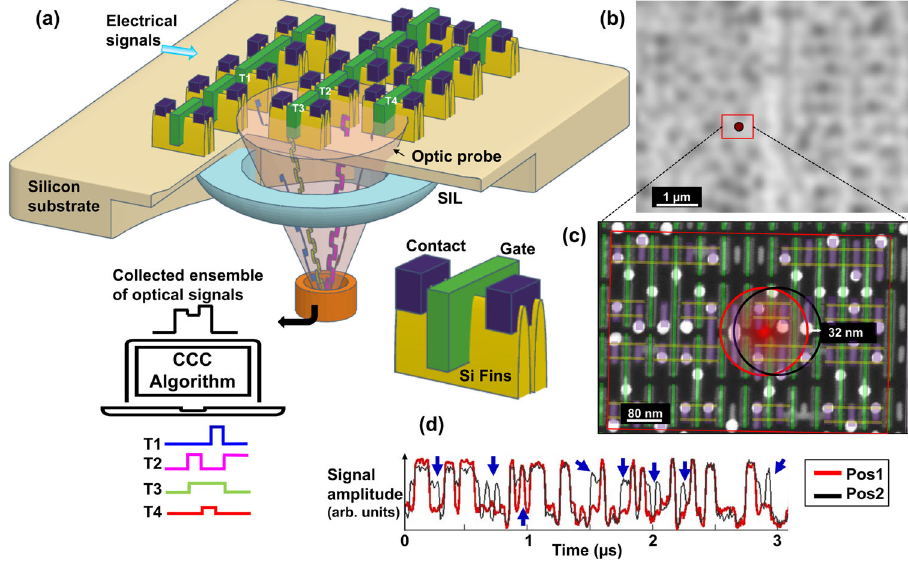
Fig. 1 | Laser Probing with algorithmic analysis to determine accurate probe position. a Schematic of LP signal collection on an IC built on sub-10nm FinFET technology.Anopticprobeisfocusedontotheactivecircuittomeasurechangesin the re fl ectance while electrical tests are executed. As multiple transistors interact withtheopticprobesimultaneously,thecollectedensembleofopticalsignalsfrom transistors T1-T4 is processed by our CCC algorithm to extract signals from indi- vidual transistors. b High-resolution LSM re fl ected micrograph using 2.9 NA and 1064nm wavelength on the area of interest is unable to resolve features useful for CADalignment due to the limitedopticalresolution. The red box indicatesthe cell